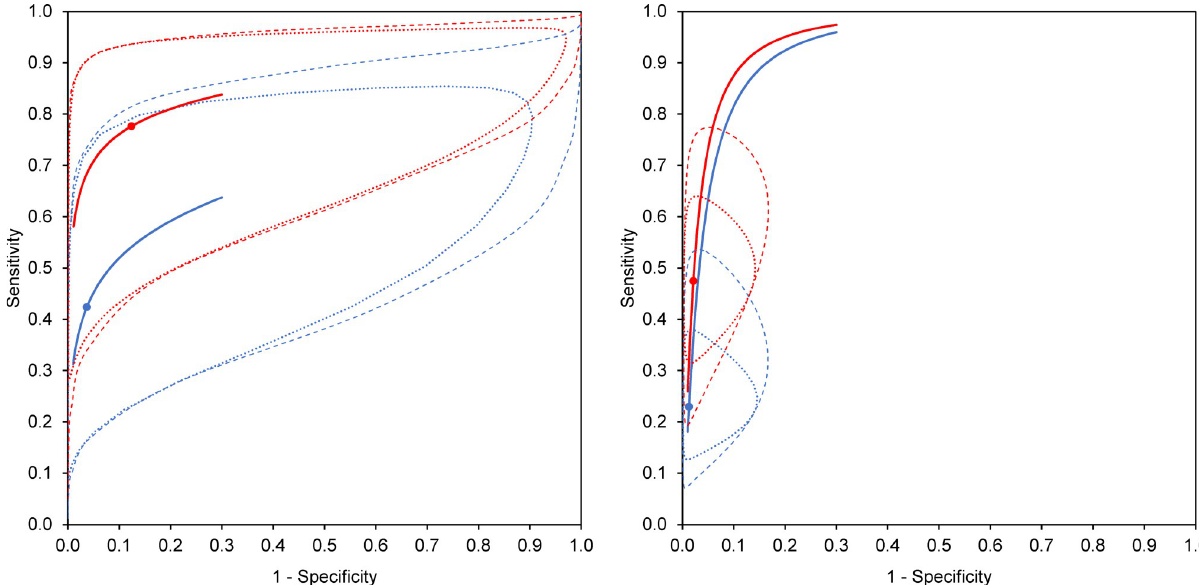
Fig 4. Comparison of summary points and hierarchical summary receiver operating characteristic plots for studies evaluating both pleural fluid Xpert MTB/RIF (blue) and Xpert MTB/RIF Ultra (red), using mycobacterial culture (left panel) and composite criteria (right panel) as reference standard for diagnosing tuberculous pleural effusion. Summary diagnostic accuracy points are depicted by solid circles. The dotted ellipses characterize the 95% confidence region around these summary estimates, while the dashed ellipses represent the 95% prediction region (area within which one is 95% certain the results of a new study will